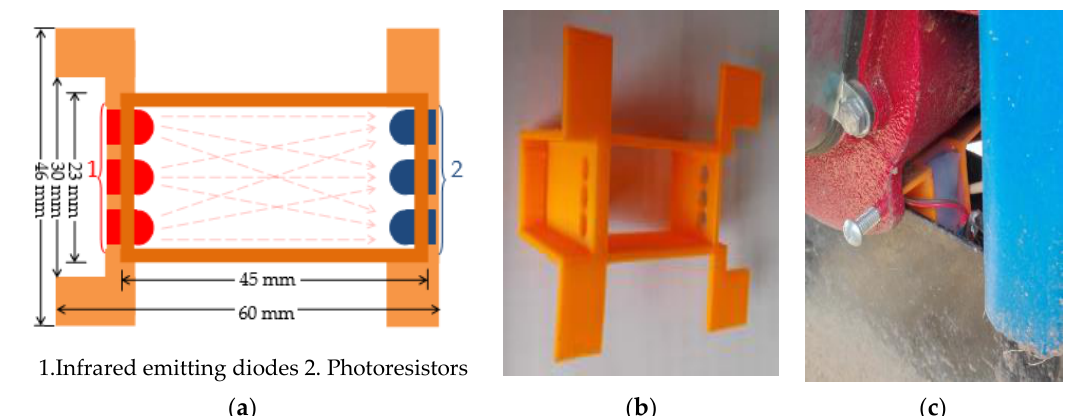
Figure 3. Photoelectric sensor design. ( a ) Schematic diagram; ( b ) a sensor shell produced by a 3D printer; ( c ) sensor installation.